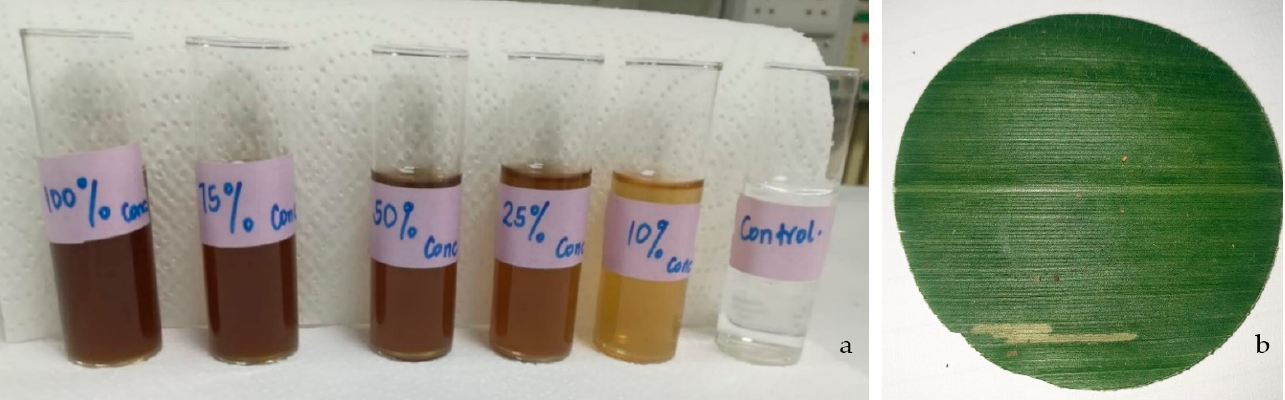
Figure 2. ( a ) Preparation of five rabbit urine doses and the control, and ( b ) a section of a leaf disk with damaged tissue as a result of feeding by fall armyworm larva.